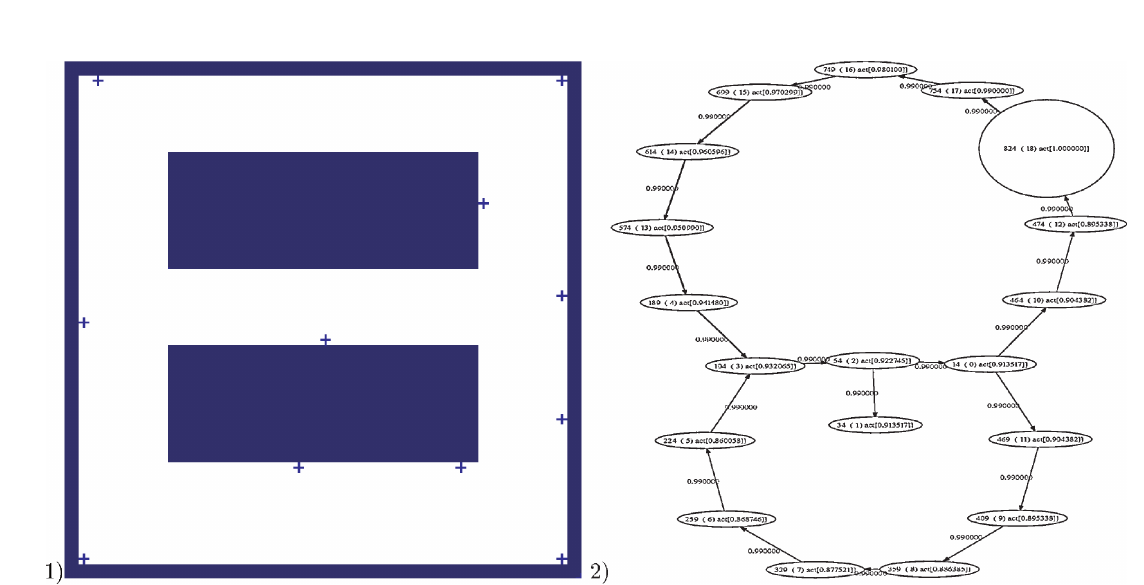
Figure 11. (1) Eight shaped environment, (2) Cognitive map build is this environment. Circles represent transitions from one place to itself. Edges link successive cells. Number in the circles indicates the activity level of the cell. Activity is 1 in the big circle on the top left (goal to reach) and diffuses along the graph. Values on the edges are the weights of the cognitive map (here, all set to 0.99). The graph has been displayed using Graphviz (Graphviz is an open source software for displaying graphs